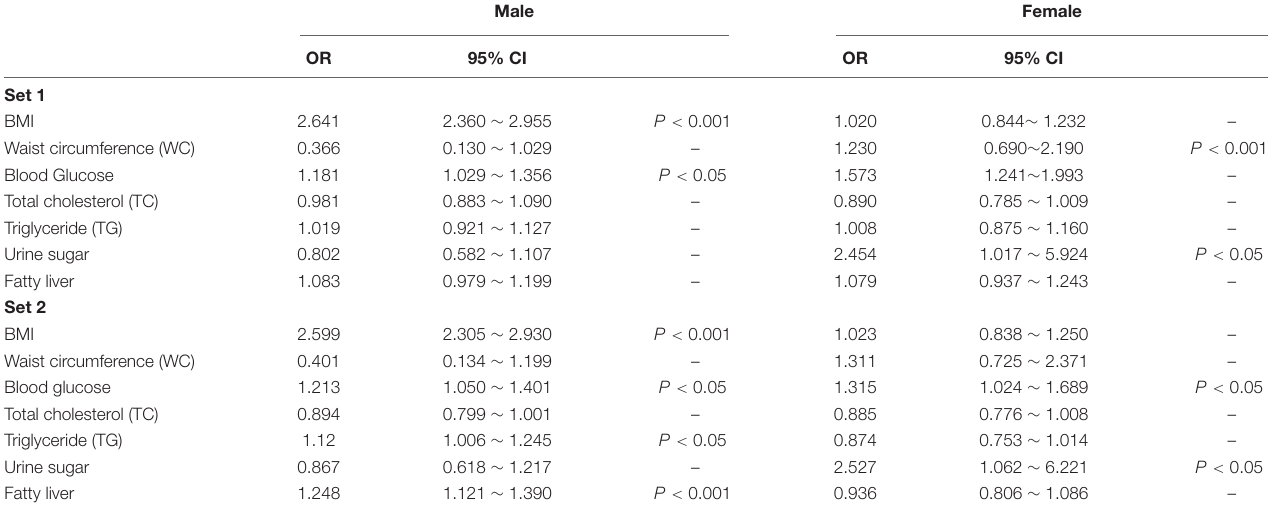
TABLE 4 | Logistic regression analysis of famine exposure and glucolipid metabolic